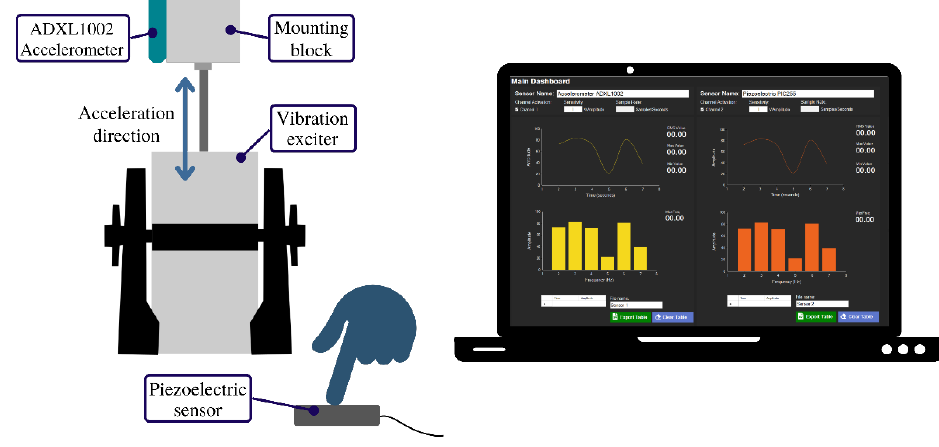
Figure 10. Evaluation arrangement.